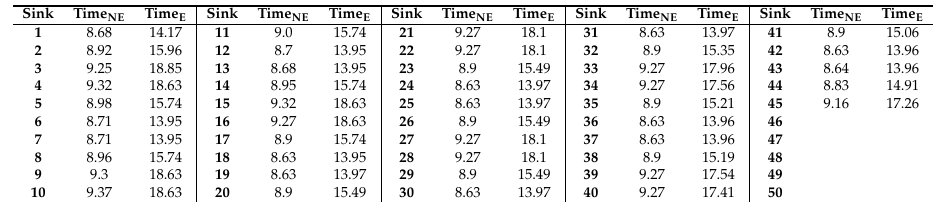
Table A14. Scenario 4: transmission times (in s) for each sink all over the transmission line. (Distance between poles is equal to 300 m, κ = 8, η = 3, NE means no encryption, E means encryption.)